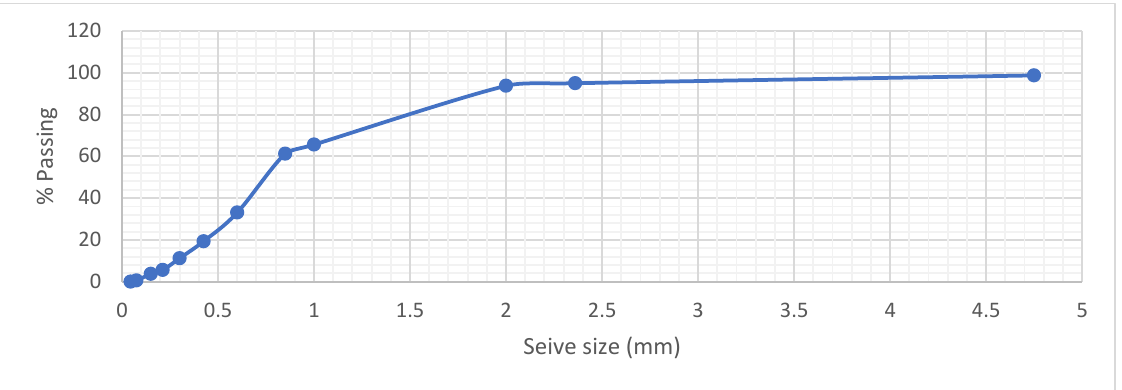
Figure 1. Gradation Distribution of utilized fine aggregates (with fineness modulus of 6.12; specific gravity of 2.578 and water absorption capacity of 1.13%).